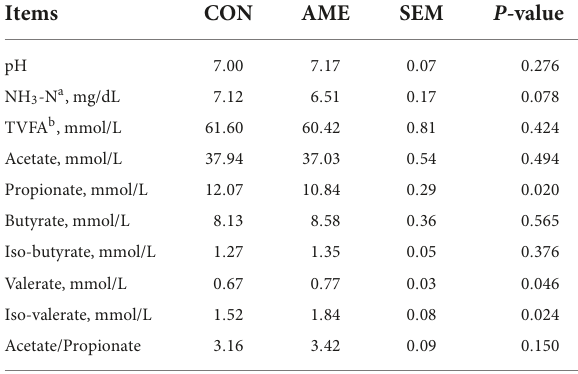
TABLE 5 Effect of AME on bacterial abundance at the phylum level in the rumen of lambs